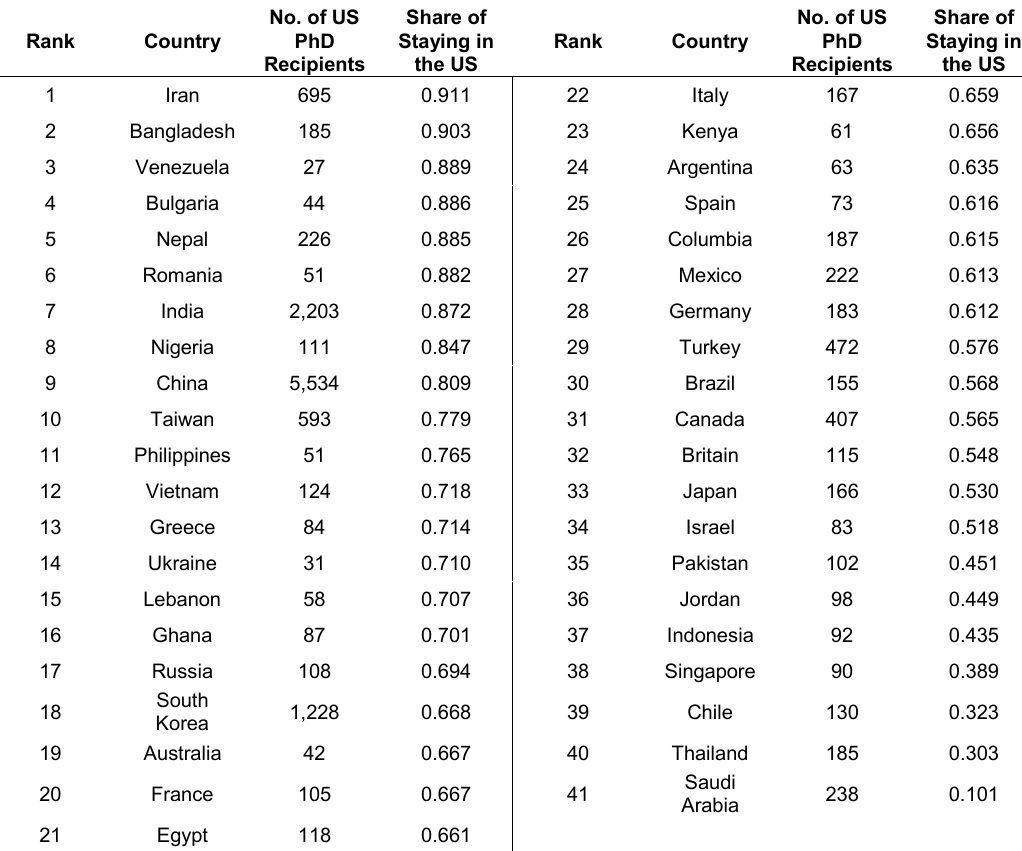
Table 3 . Rankings of Share of new Ph.D.’s Staying in the U.S. by Country in 2016 6 .